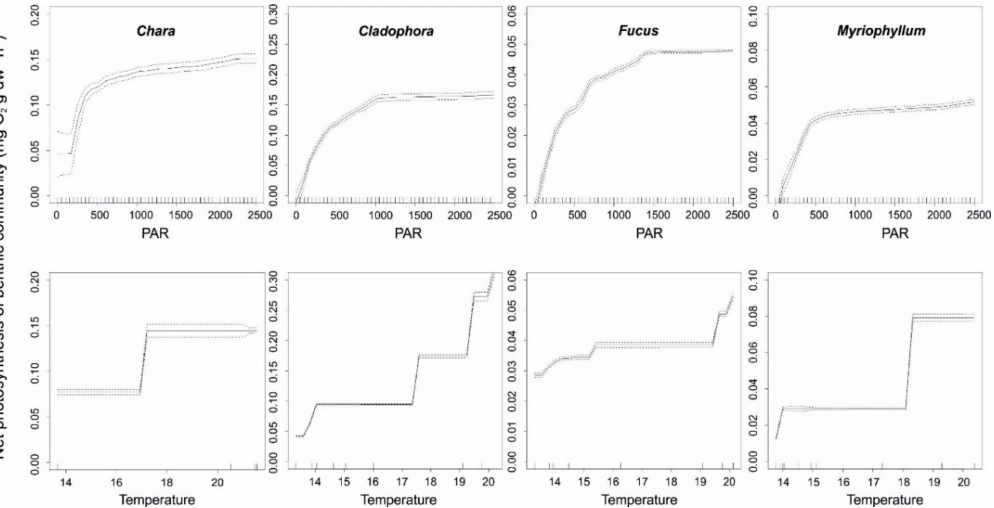
Figure 7. Standardized functional–form relationships ( ± standard error) showing the effect of envi- ronmental variables on the net photosynthesis of the studied plant classes, whilst all other variables are held at their means. Upward tickmarks on x -axis show the frequency distribution of data along this